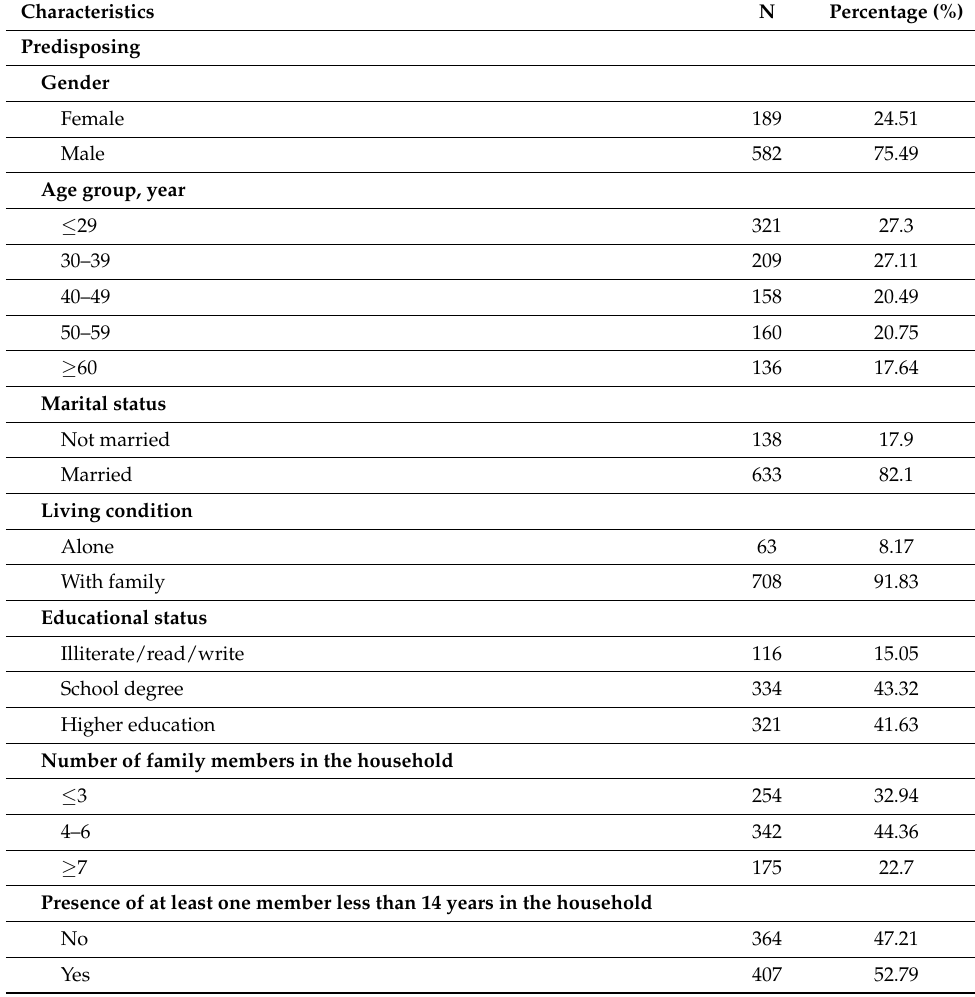
Table 1. The surveyed individuals with NCD’ characteristics (N = 771).